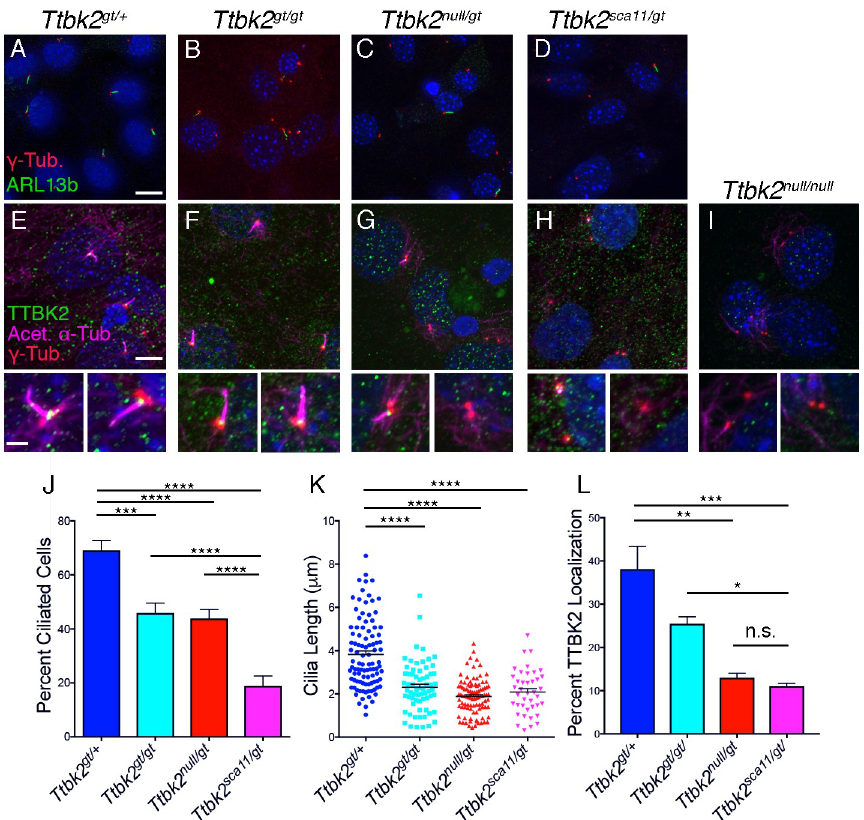
Fig 5. Ciliary defects are evident in Ttbk2 hypomorphic mutant cells. (A-D) Representative images of MEFs taken from the embryos of the indicated and serum starved for 48-hours to induce ciliogenesis. Cilia were immunostained for ARL13b (green) to label cilia and γ -Tubulin (red) to label centrosomes. Scale bar = 20 μ m. (E-I) Localization of endogenous TTBK2 (green) in MEFs of each indicated genotype. Cells were counterstained with γ -Tubulin (red) to label centrosomes and Acetylated α -Tubulin (magenta) to label cilia. Staining of Ttbk2 null/null cells is shown as a negative control. Lower panels show zoomed images of from individual cells seen in the top panel. Scale bar = 10 μ m, 2 μ m for zoomed panels. (J) Quantification of the percentage of ciliated cells from MEFs of each genotype following 48 hours of serum starvation. Cilia frequency is reduced in all mutants compared with heterozygous cells, and is further reduced in Ttbk2 sca11/gt cells relative to Ttbk2 null/gt . Bars represent the mean percentage of ciliated cells across 3 experiments with 3 replicates each (n = 289, Ttbk2 gt/+ ; n = 252, Ttbk2 gt/gt ; n = 584, Ttbk2 null/gt ; n = 340 Ttbk2 sca11/gt ). Error bars denote SEM. (K) Quantification of cilia length in MEFS of each genotype following 48 hours of serum starvation. Cilia in each of the mutant MEFs were significantly shorter than heterozygous cells, but did not differ significantly from each other. (L) Quantification of the percentage of cells with endogenous TTBK2 localized to the centrosome following 48 hours of serum withdrawal. Ttbk2 mutant cells, particularly Ttbk2 null/gt and Ttbk2 sca11/gt have reduced TTBK2 at the centrosome, however these two genotypes did not differ from one another with respect to TTBK2 localization. For J-L, stars denote statistical comparisons between the indicated groups (1- way ANOVA with Tukey-Kramer post hoc test, ���� denotes p < 0.0001, ��� denotes p < 0.001, �� denotes p = 0.0017, � denotes p =